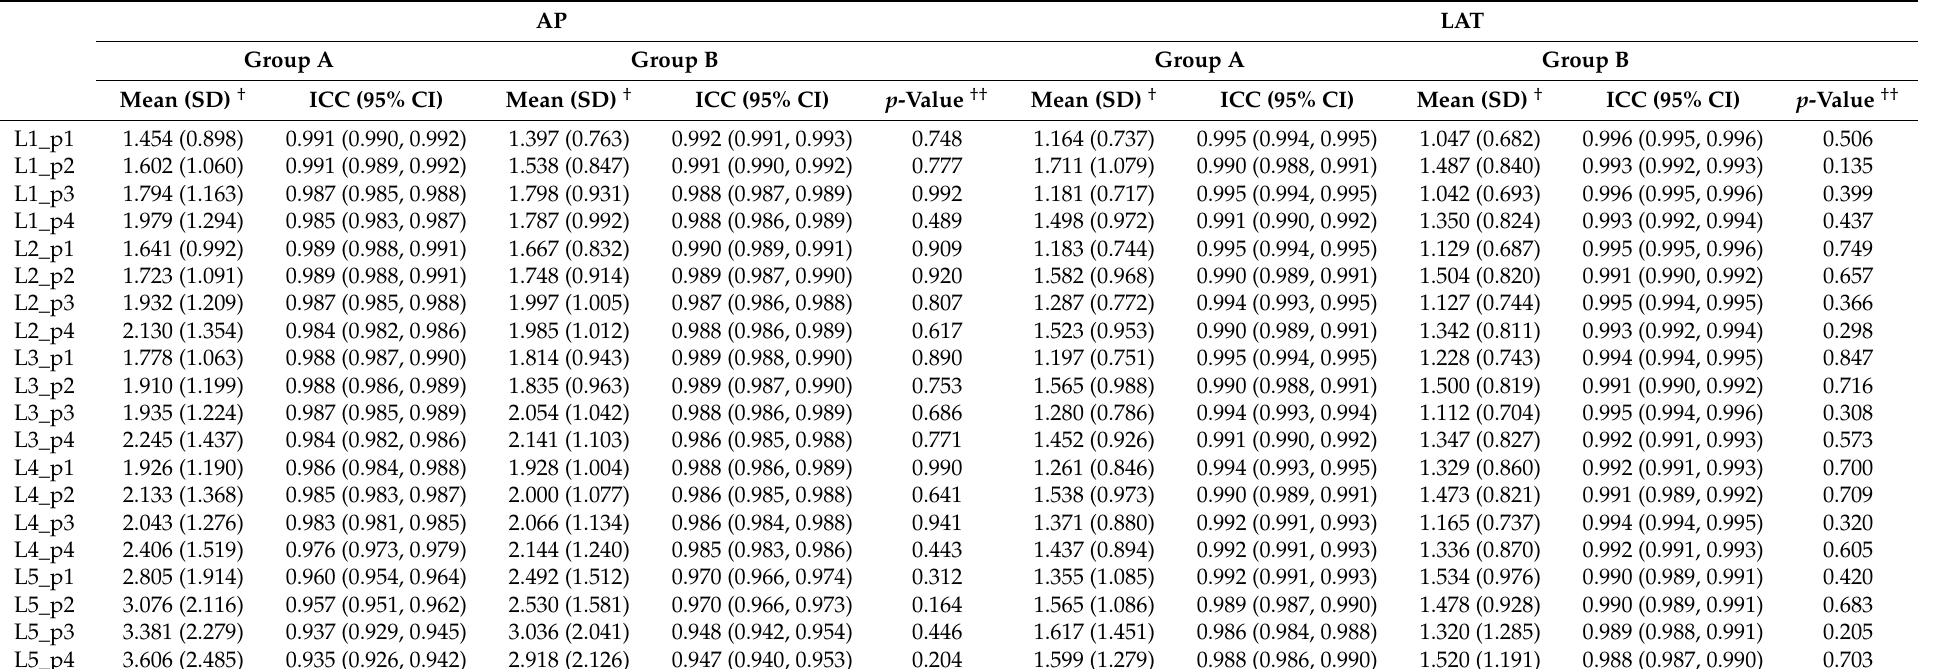
Table 1. Mean variations and inter-rater reliability for landmark points according to rater group. AP LAT Group A Group B Group A Group